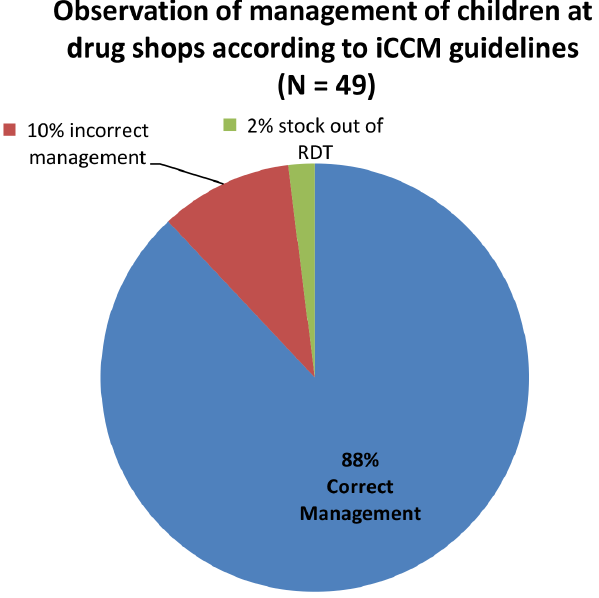
Fig. 2. Quality of assessment of children at drug shops, from direct observations in the intervention